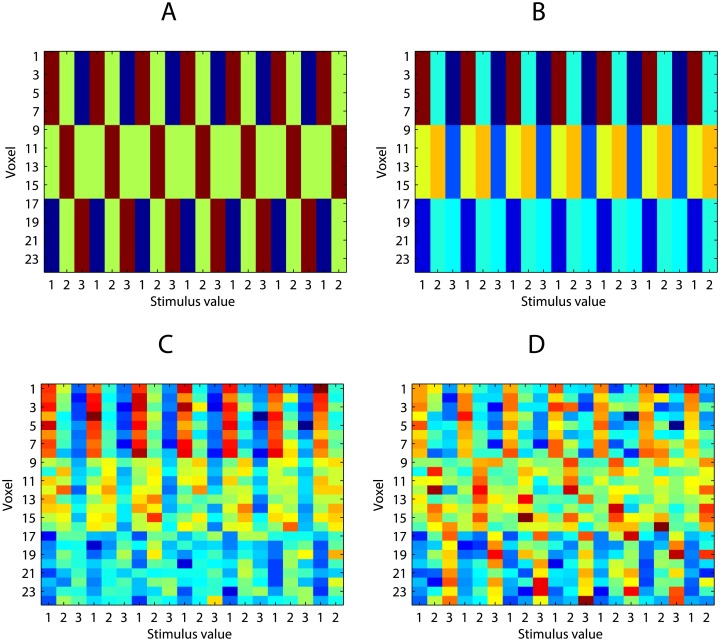
Simulation of sensory adaptation.(A) Voxel response matrix based on positional preferences. (B) Voxel response matrix: positional preferences + sensory adaptation. (C) Voxel response matrix: positional preferences + sensory adaptation + Gaussian noise. (D) Voxel response matrix z-scored. Column-wise means are zero.